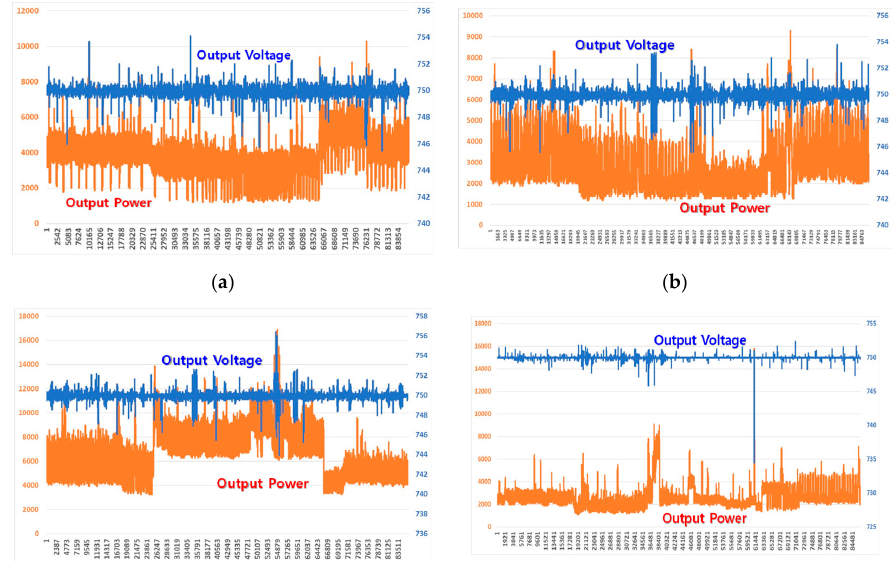
Figure 9. Results from the DC distribution demonstration site. ( a ) Spring, ( b ) summer, ( c ) autumn, and ( d )